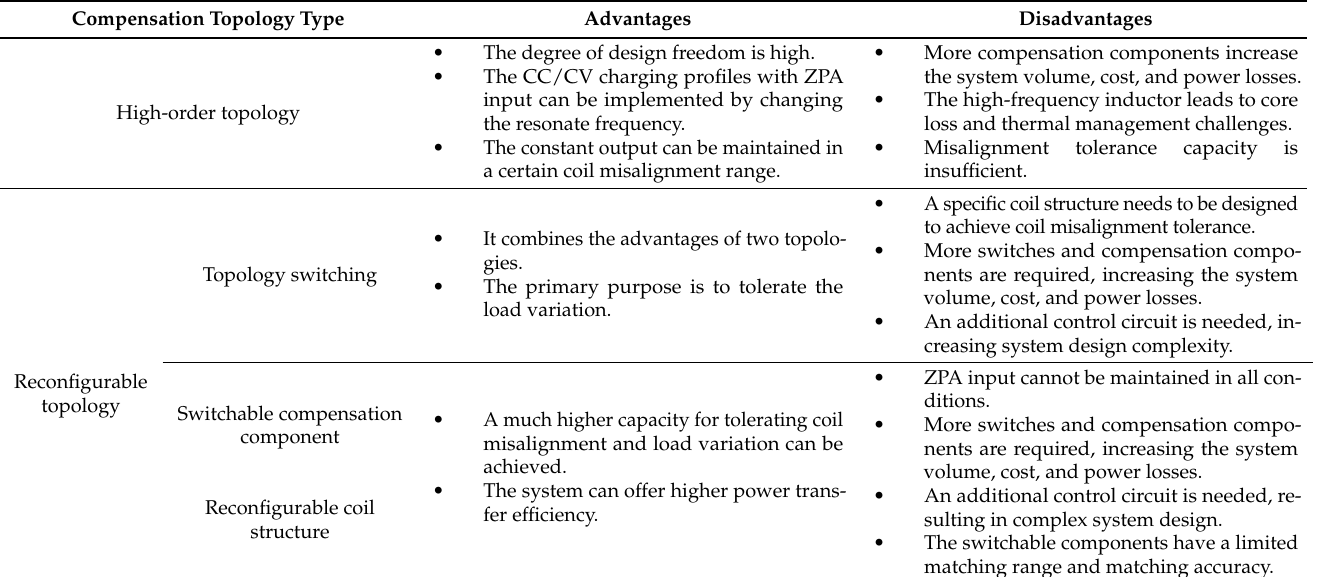
Table 2. Comparison of different highly flexible compensation